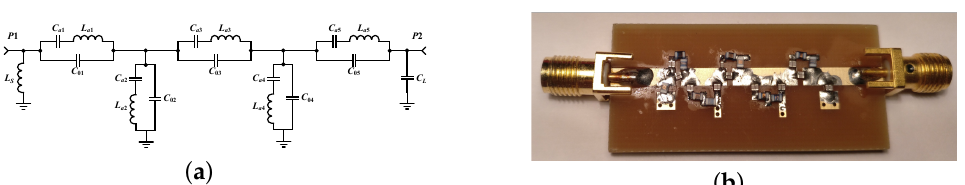
Figure 15. ( a ) Equivalent electric circuit using the Butterworth-Van Dyke model for the designed filter, and ( b ) the fabricated prototype using lumped elements.